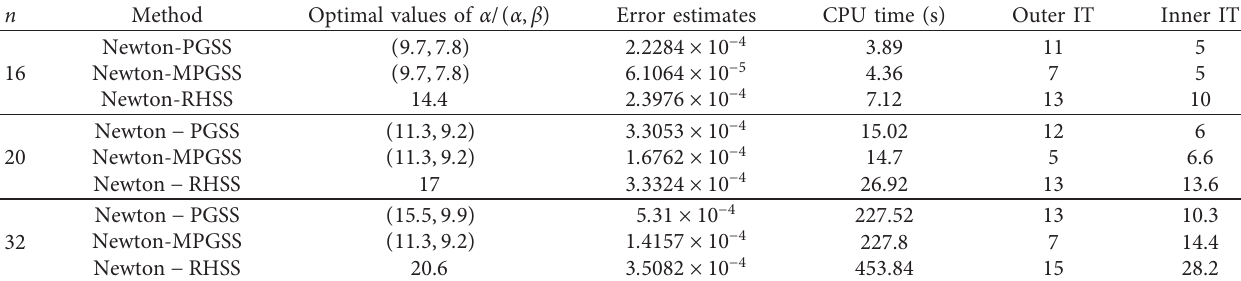
Table 1: Numerical results of inexact Methods for v � 0.1 and η � 0.4.